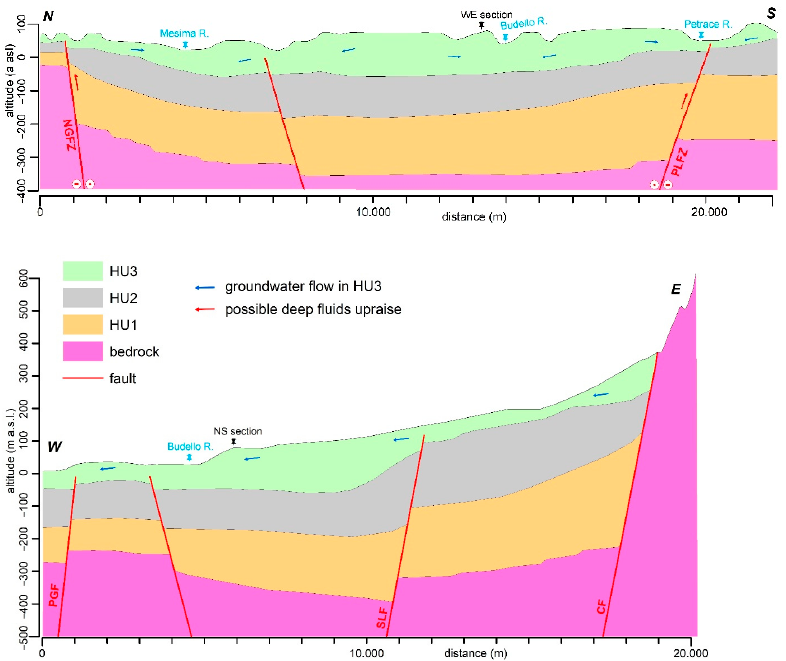
Figure 10. Hydrogeological cross-sections (NS and WE) of the Gioia Tauro Plain (vertical scale × 10; see Figure 1 for the profile location).